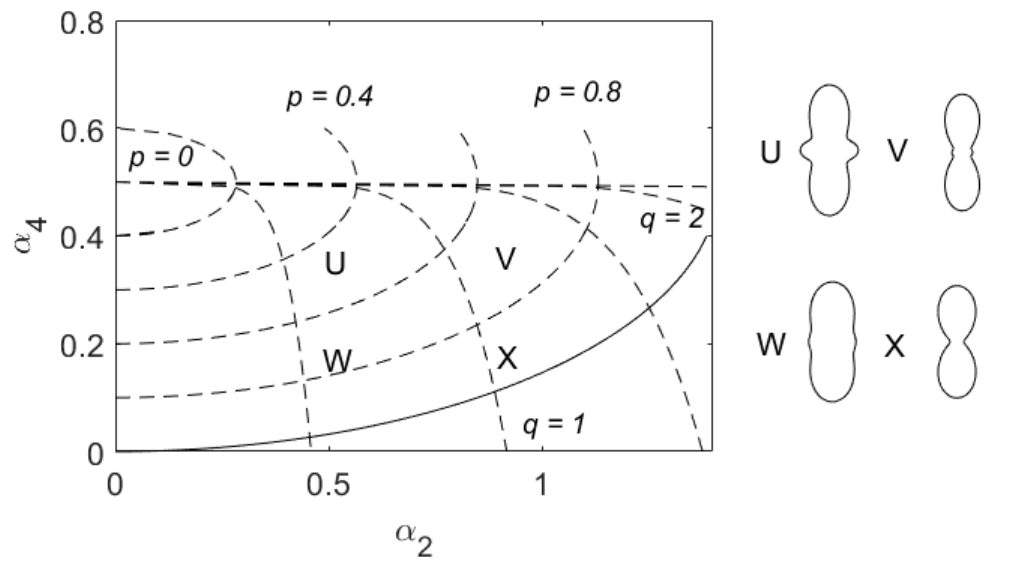
Figure 1. Plane of shape parameters α 2 and α 4 , showing constraint boundary (solid curve, Equation (2) in Reference [27] )) and contours of the orthogonal shape variables ( p , q ). Four symmetric copolar-linear polarization pattern (CLPP) forms (Equation (5) of Reference [23] ) U ( α 2 = 0.5, α 4 = 0.3), V ( α 2 = 0.9, α 4 = 0.3), W ( α 2 = 0.5, α 4 = 0.15) and X ( α 2 = 0.9, α 4 = 0.15) are shown, along with the position of their parameters on the ( α 2 , α 4 ) plane.